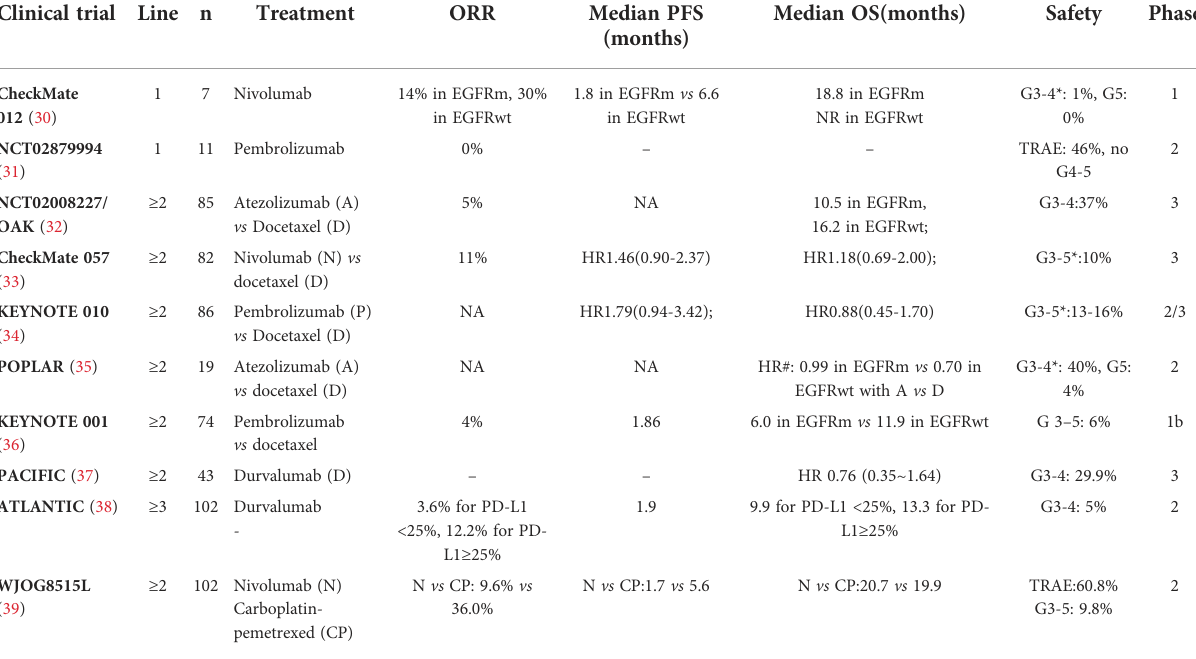
TABLE 1 EGFR-mutant NSCLC patients bene fi t little from PD-1/PD-L1 monotherapy. Clinical trial Line n